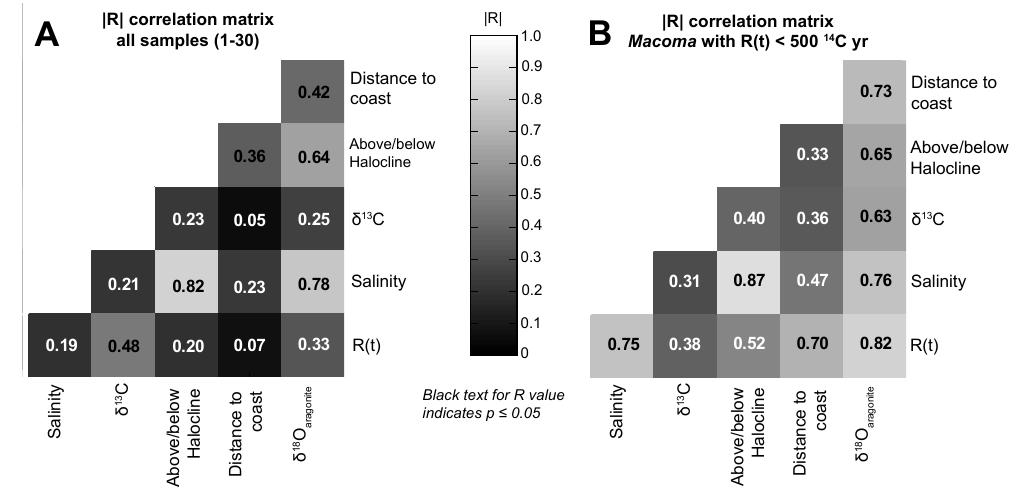
Fig. 4. (A) Correlation coefficient matrix for all sample locations. (B) Correlation coefficient for all Macoma samples with R(t)< 500 14 Cyr. For both figures: values shown are absolute values of correlation coefficient R , when written with black text p ≤ 0.05. Correlations based on values in Table 1 and in